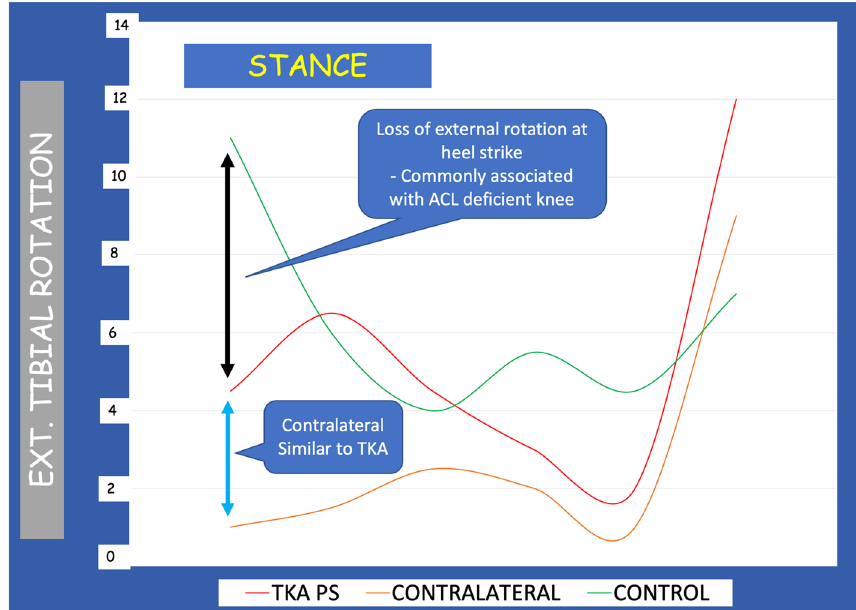
Fig. 4 Analysis of the external tibial rotation during the stance phase of gait. The bi-cruciate substituting PS TKA group showed a significant loss of external rotation at heel strike, both in the prosthetic knee as well as in the contralateral knee. This paradox motion is typical of anterior cruciate ligament (ACL) deficient